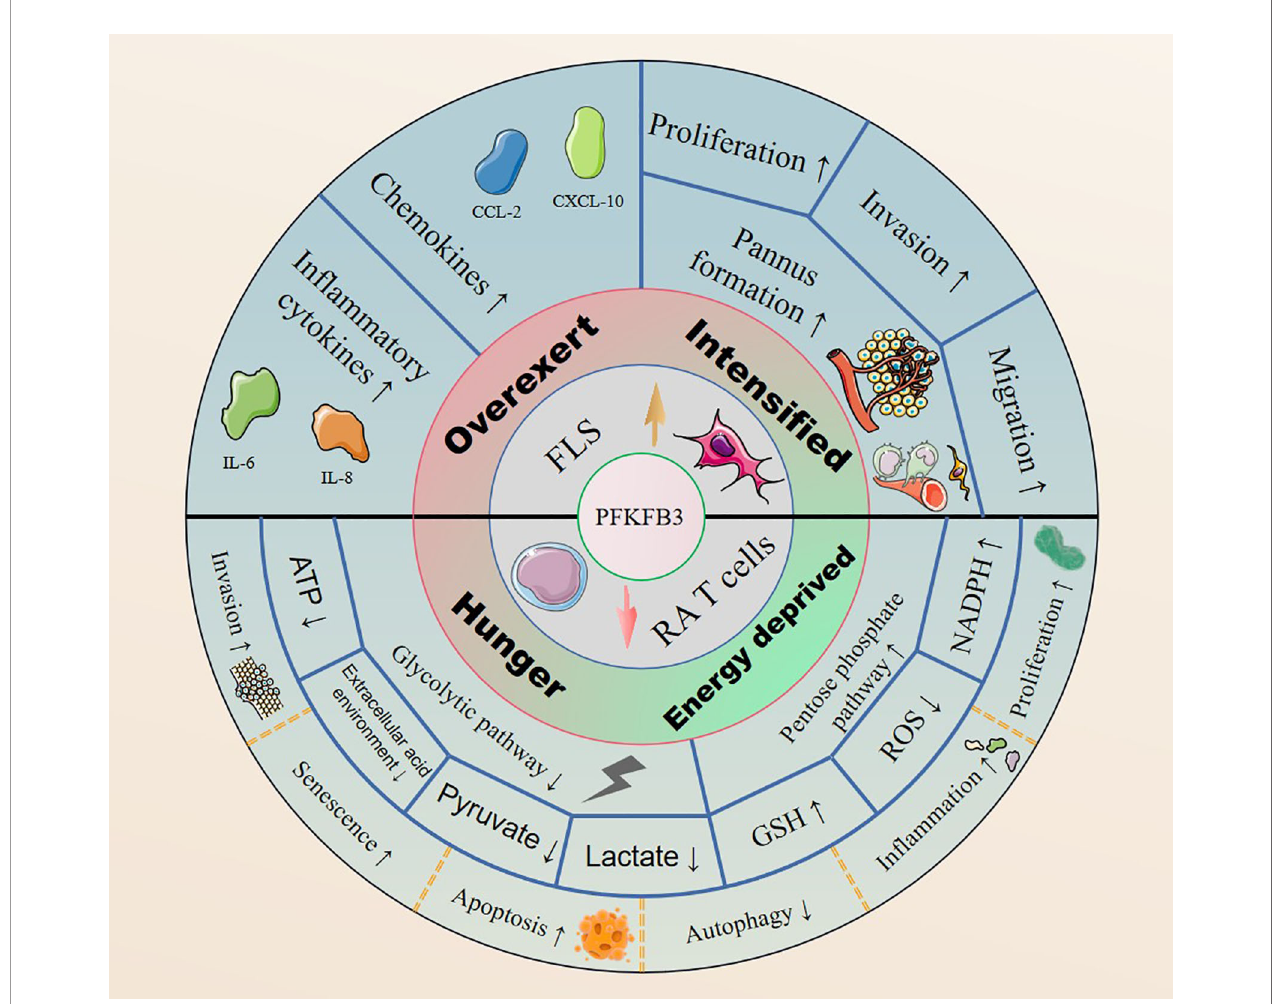
FIGURE 2 | PFKFB3 is highly expressed in RA FLSs, it upregulates the expression of in fl ammatory cytokines and chemokines, and facilitates cell proliferation, invasion and migration by promoting pannus formation. In contrast, PFKFB3 is expressed at low levels in RA T cells, generating an RA pathological phenotype with an inhibited glycolytic pathway and enhanced PPP